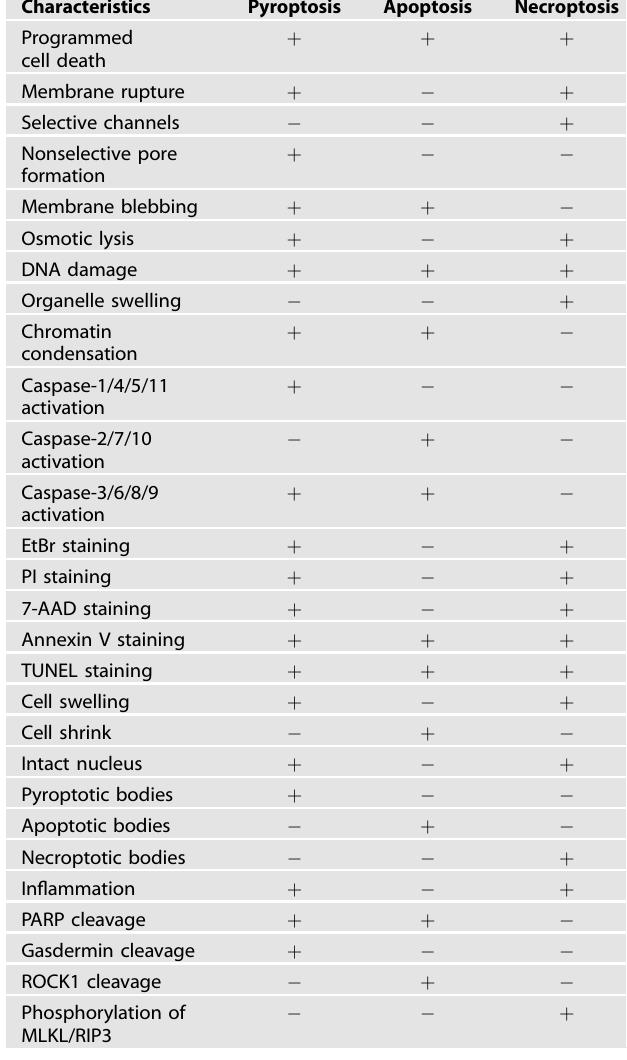
Table 1. Characteristics of similarities and differences in pyroptosis, apoptosis and